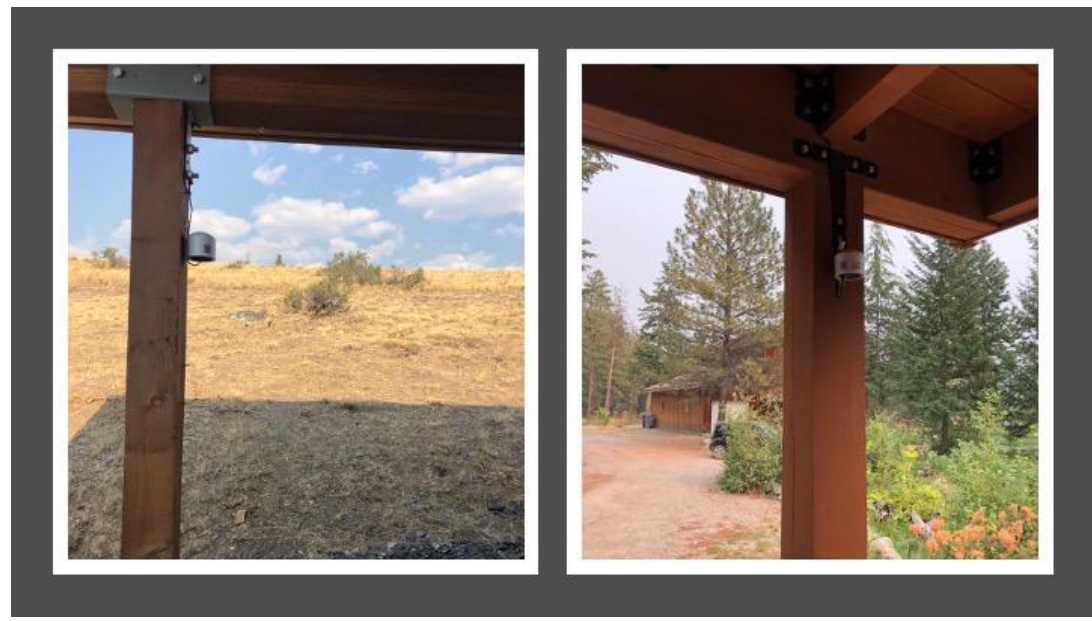
Figure 1. Examples of CAA (Clean Air Ambassadors) Purple Air monitors .